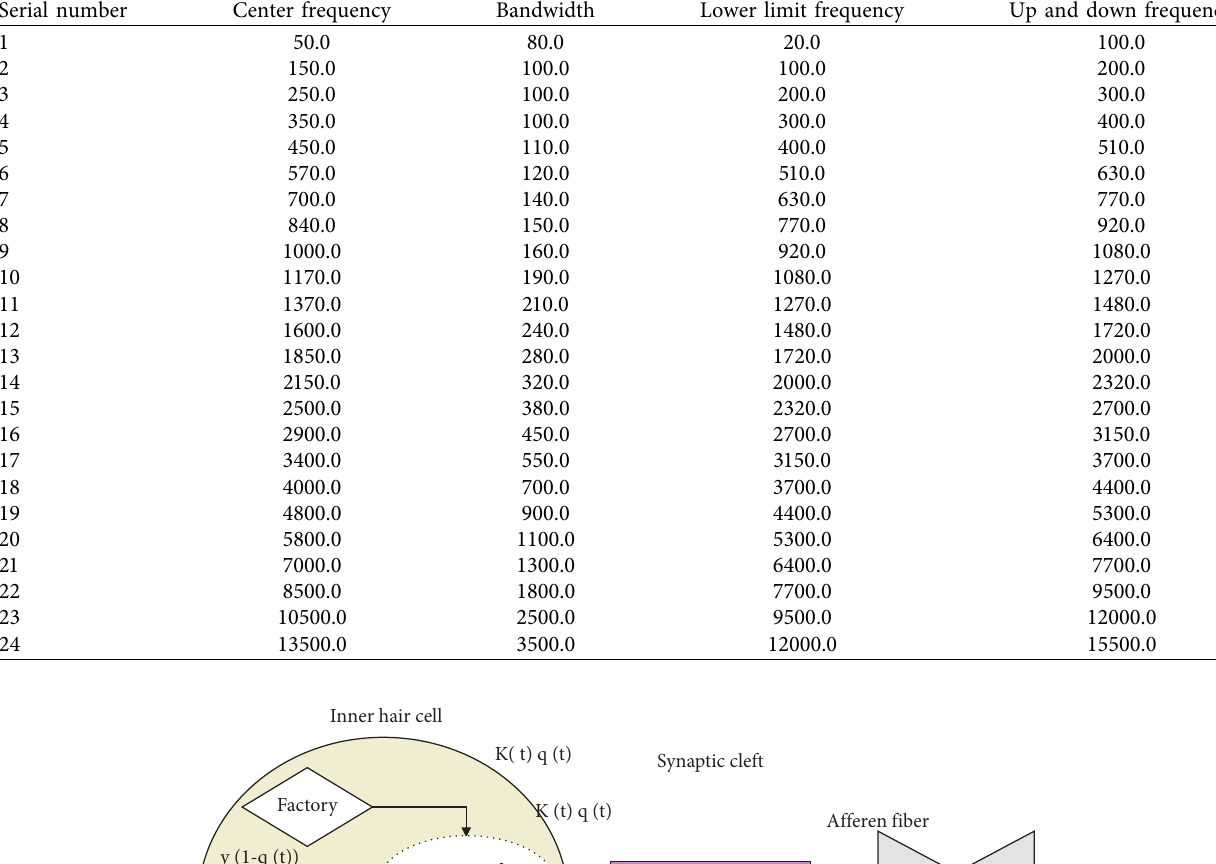
Table 1: Filter bandwidth parameter table (frequency: Hz).